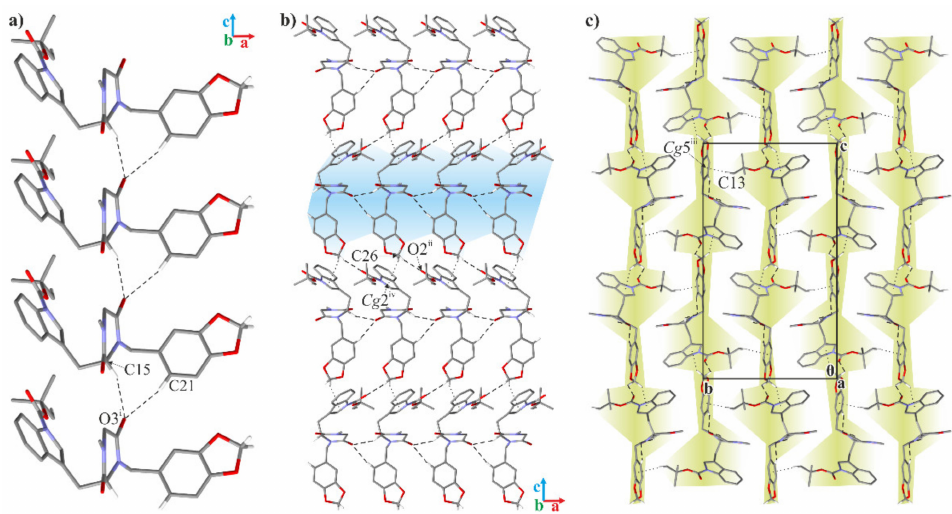
Figure 5. Arrangement of molecules of 12a in the crystal, where: ( a ) chain of molecules running along [001] direction; ( b ) single layer of molecules spreading along (100) plane (single chain of molecules is highlighted in blue); ( c ) general view on layered supramolecular architecture of compound viewed along a-direction (single-layers are highlighted in light-green). The H-atoms not involved in intermolecular interactions have been omitted for clarity. The C–H · · · O hydrogen bonds are represented by dashed lines, while the C–H · · · π contacts by dotted lines. Symmetry codes: (i) x − 1,